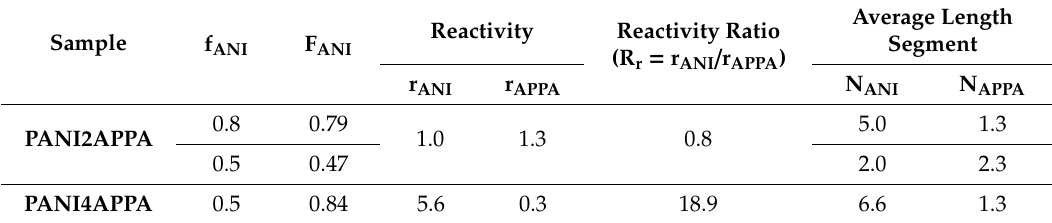
Table 2. Co-monomer ratios in the feed (f), copolymers composition (F), reactivity ratios, and average length segments of PANIAPPA copolymers. Average Length Reactivity Reactivity Ratio Sample f ANI F ANI Segment (R r = r ANI / r APPA ) r ANI r APPA N ANI N